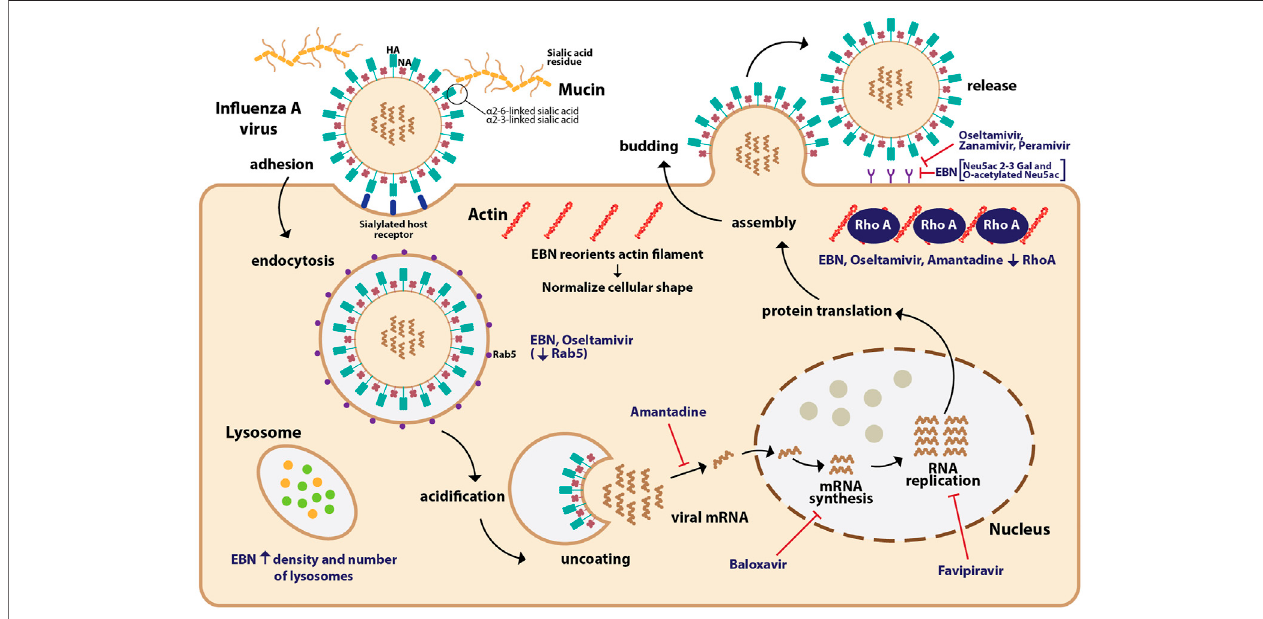
FIGURE1 | The mechanism ofaction ofEBN and anti-viraldrugs on in fl uenza A virus(IAV). The IAV binds totheterminal sialic acid residues on mucins, particularly through α 2-6 and α 2-3 linkages leading to endocytosis of IAV into the host cell. The IAV core undergoes acidi fi cation allowing viral RNPs to be released into the cytoplasm. The IAV genetic material is transcribed and translated to produce viral materials, which once assembled, bud out from the infected cell. Anti-viral drugs such asbaloxavirinhibitviralmRNAsynthesis,favipravirinhibitsRNAreplication,amantadineinhibitsthereleaseofviralmRNA,andneuraminidaseinhibitors(oseltamivir, zanamivir, and peramivir) inhibit the release of the IAV. EBN increases the density and number of lysosomes in infected cells. Similar to oseltamivir, EBN reduces the expression ofRab5,whichfacilitatestheendocytosisofIAV.EBNreorientstheactin fi lamentandnormalizesthecellular shapeofinfectedcells.Similartooseltamivirand amantadine, EBN also reduces the expression ofRhoA, a protein involved in actin fi lament polymerization. EBN, through its sialic linkages such as Neu5Ac 2-3 Gal, and O-acetylated Neu5Ac may prevent the release of IAV.